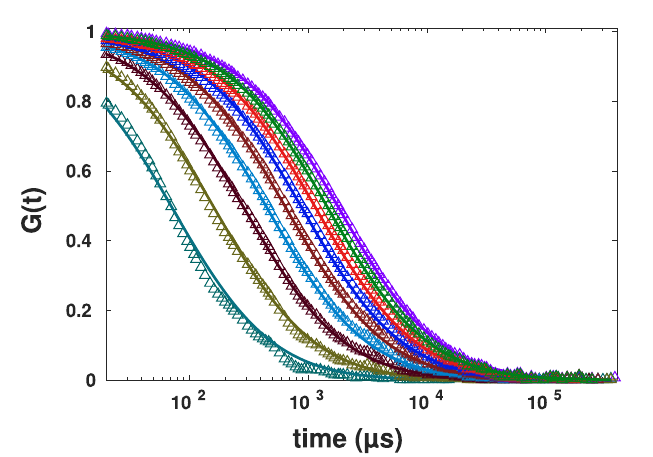
Figure 3. Simulation results for FCS curves calculated from photon counts (blue circles) and from restored intensity traces (red asterisks) fitted to Eq. 5 (lines) for normal (upper line) and anomalous (lower line) diffusion. Note the almost complete coincidence of data.